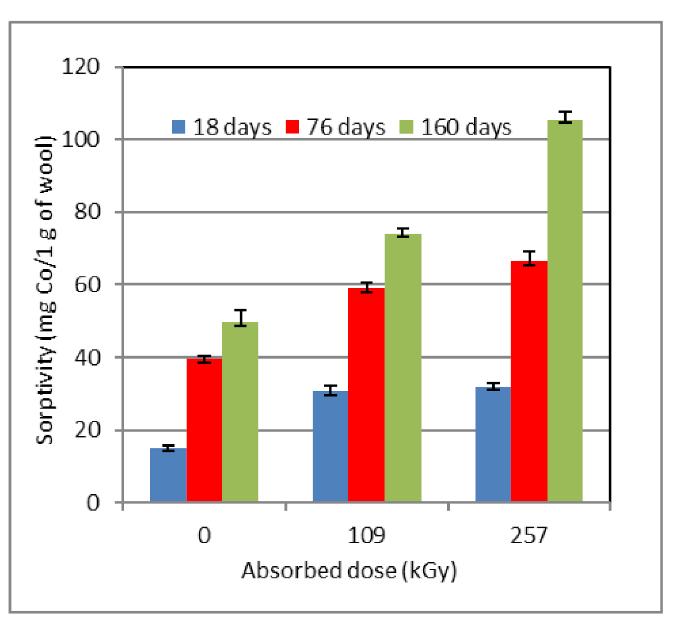
Figure 6. Time sorptivity variation with absorbed dose for wool pre-conditioned at 53%